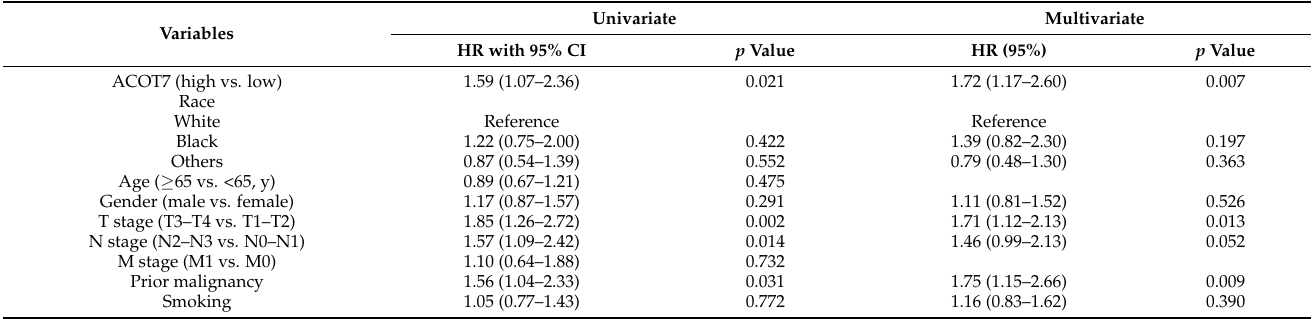
Table 1. Univariate and multivariate Cox regression analyses of ACOT7 and clinical characteristics in LUAD from TCGA database.